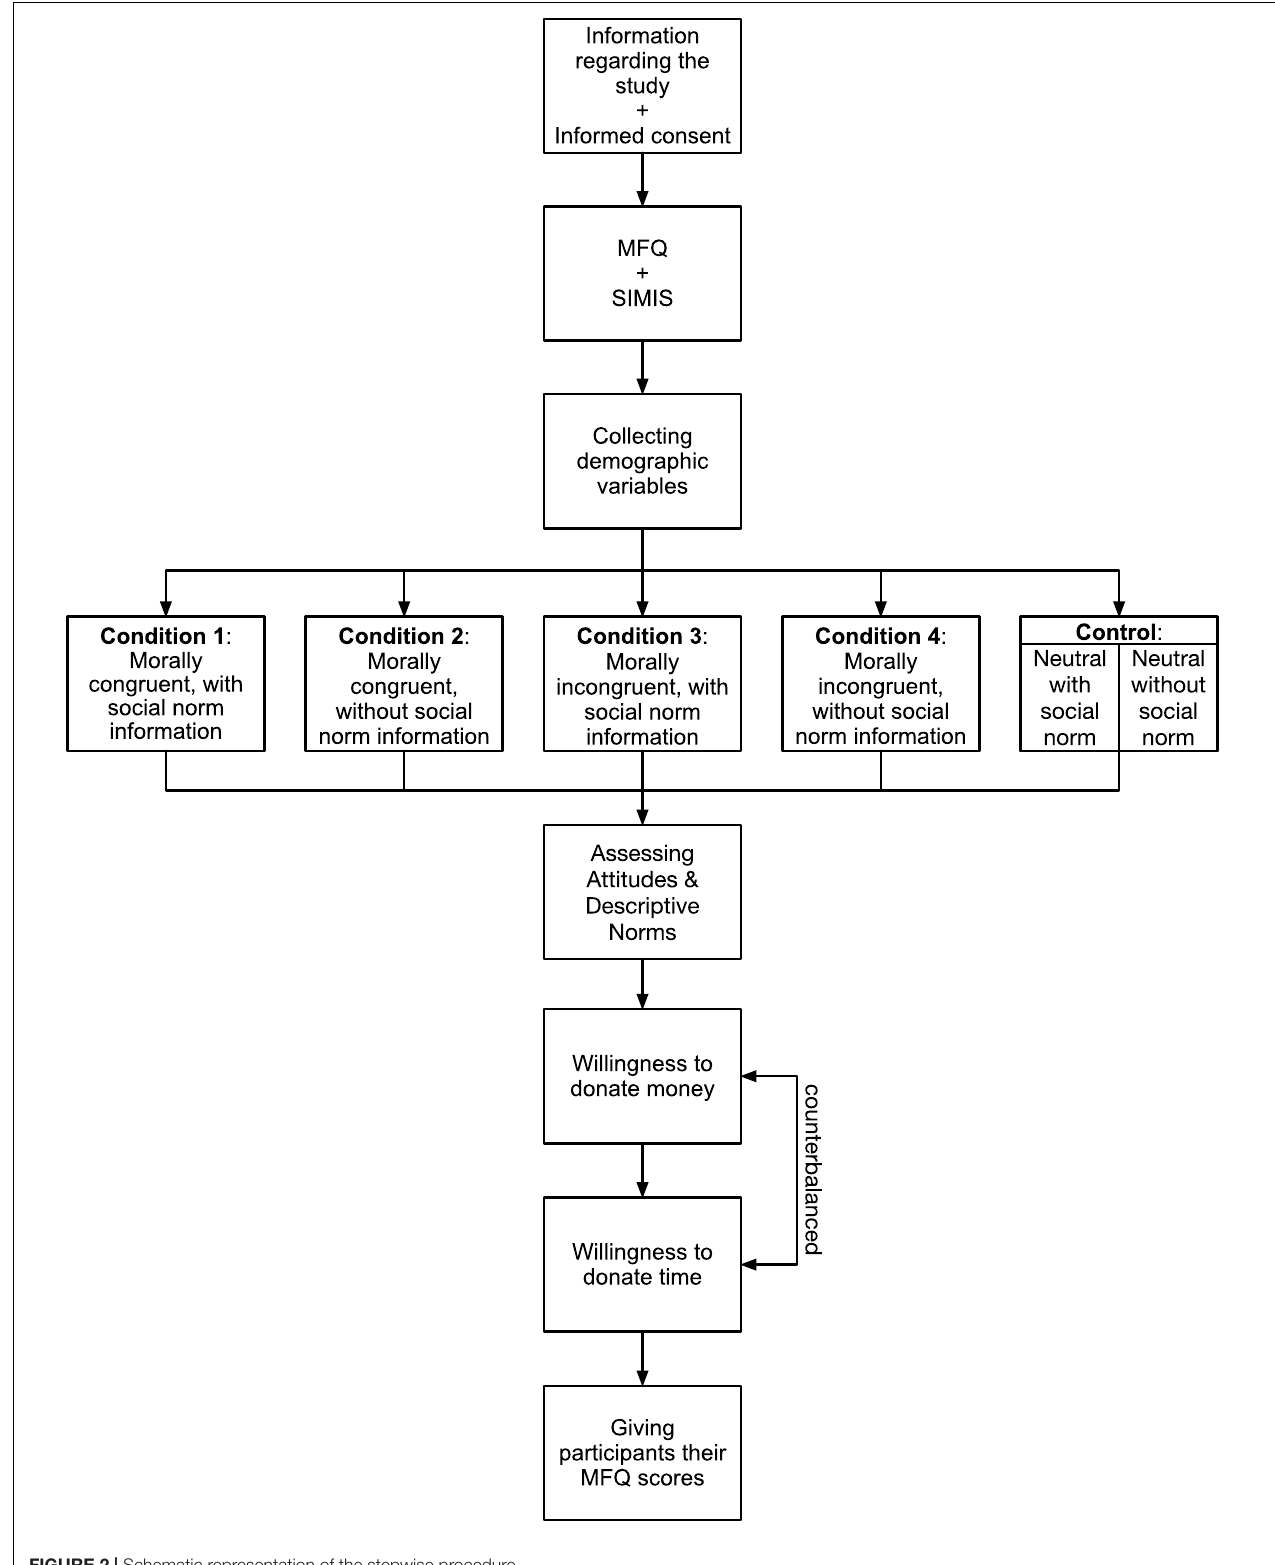
FIGURE 2 | Schematic representation of the stepwise